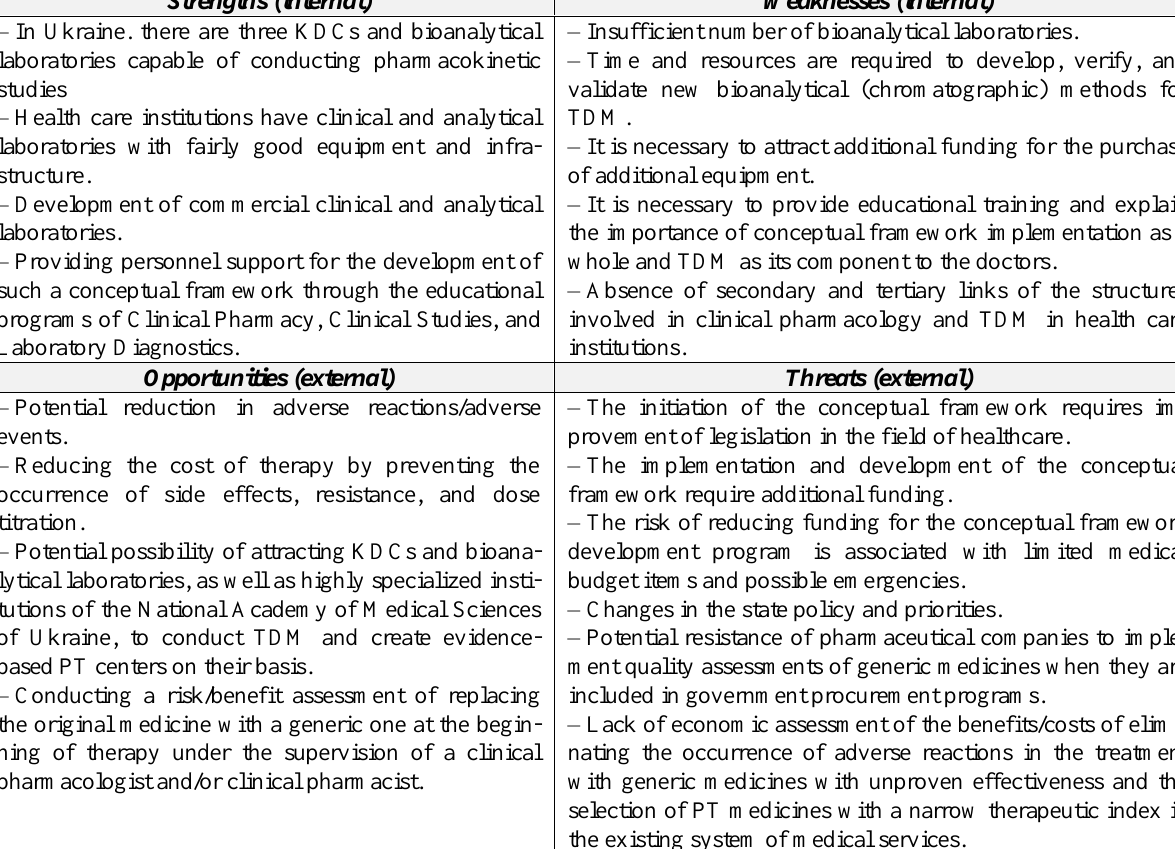
SWOT analysis for the conceptual framework implementation of evidence-based medicine substitution in Ukraine Strengths